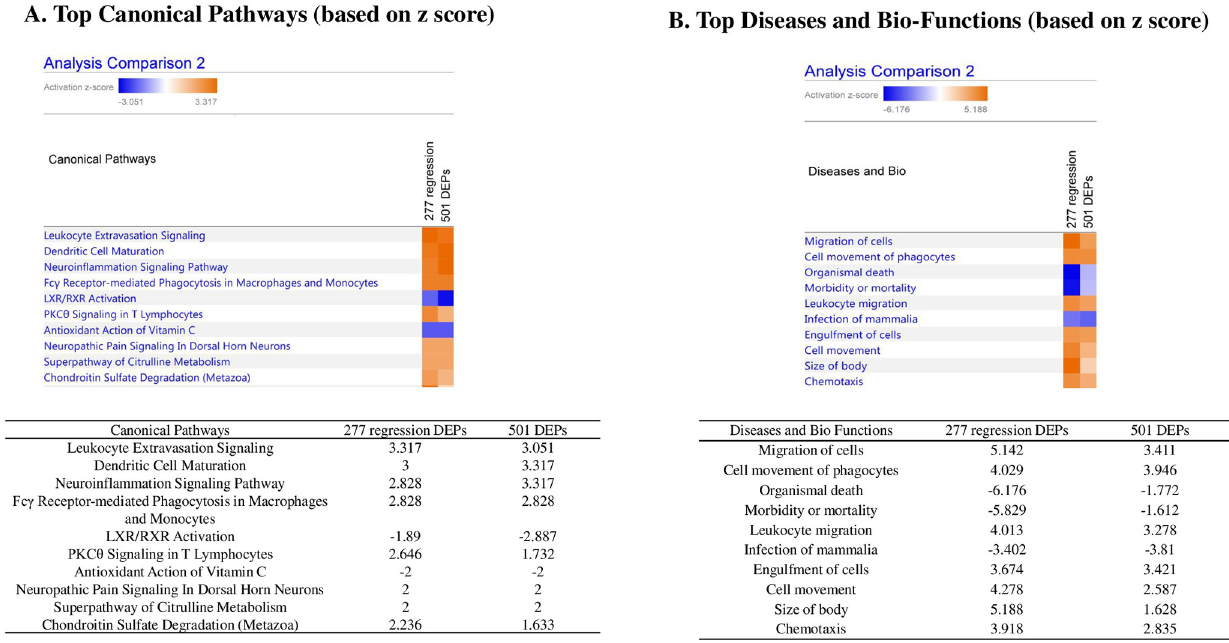
Fig 5. The Ingenuity pathway analysis (IPA) showed crucial pathway related with SCIT. A. Top 10 canonical pathways of 501 DEPs in asthma/control and 277 regression DEPs were listed in the table based on z-scores. B. Top 10 diseases and biofunctions of 501 DEPs in asthma/control and 277 regression DEPs were listed in the table based on